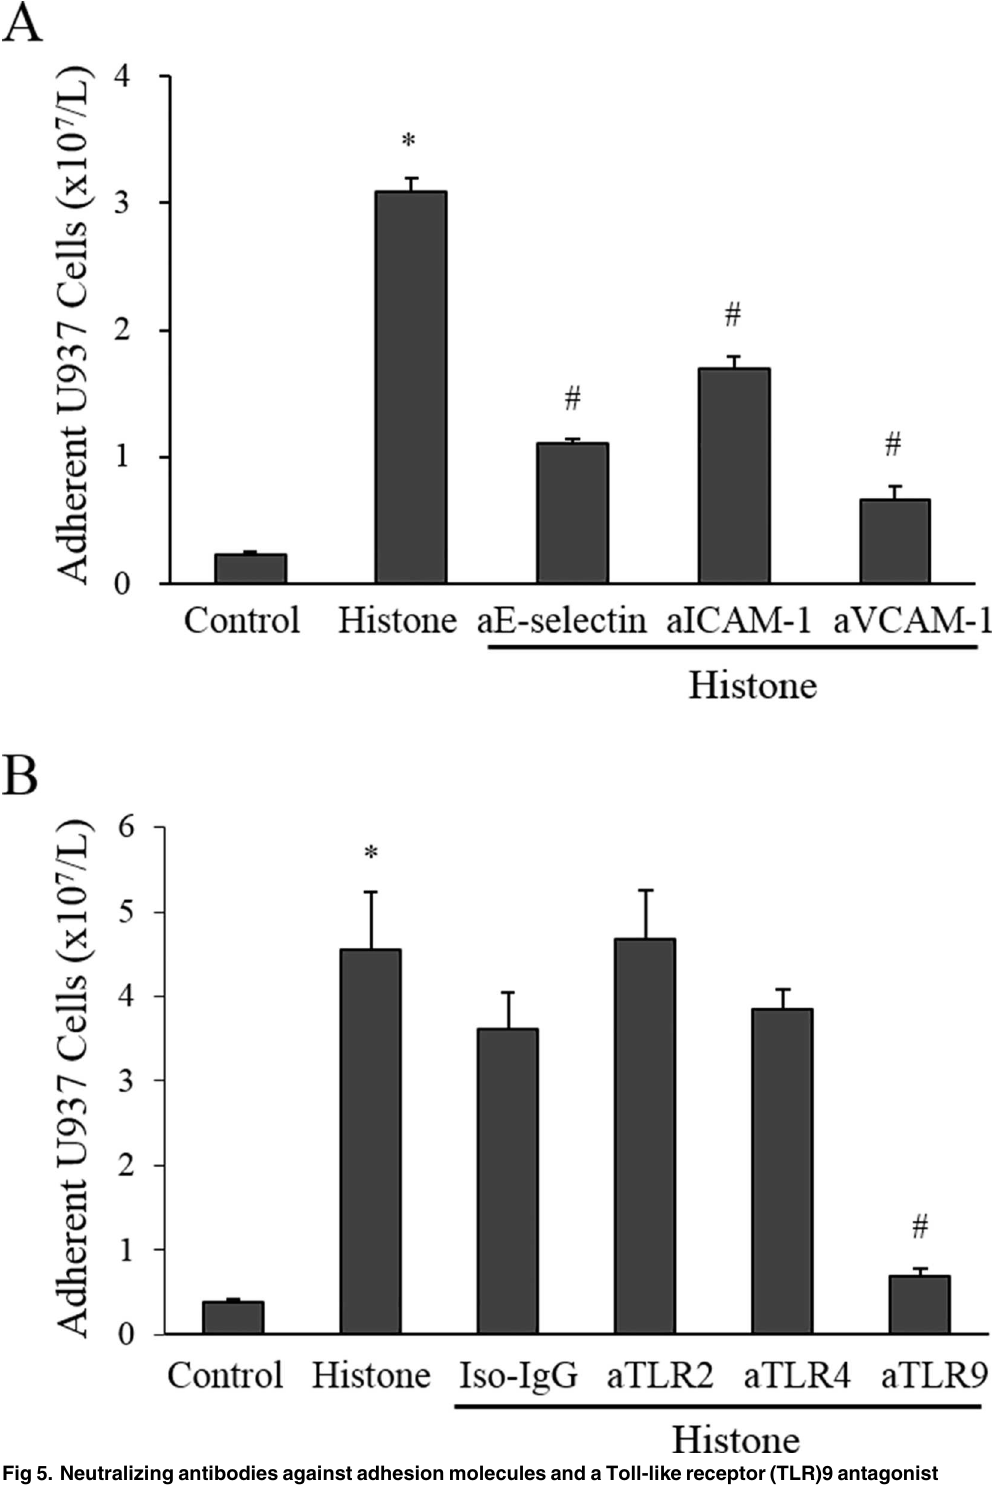
Fig 5. Neutralizing antibodies against adhesion molecules and a Toll-like receptor (TLR)9 antagonist inhibit leukemic cell adhesion to histone-treated endothelial cells (EA.hy926; hEC). (A) Histone-treated hEC were treated with neutralizingantibodiesagainst adhesionmolecules(50 μ g/mL anti-E-selectin, 10 μ g/mL anti- ICAM-1, or 30 μ g/mL anti-VCAM-1) for 10 min. Then U937 cells were added and incubatedfor 30 min, and the adherentU937 cells were counted. (B) Antagonists of TLR2 (50 μ g/mL), TLR4 (50 μ g/mL) and TLR9 (50 μ M)